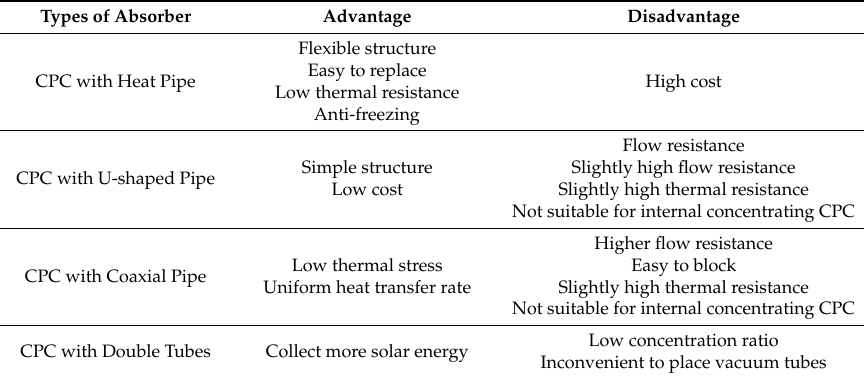
Table 5. Comparison of di ff erent absorbers of tubular absorber CPC.